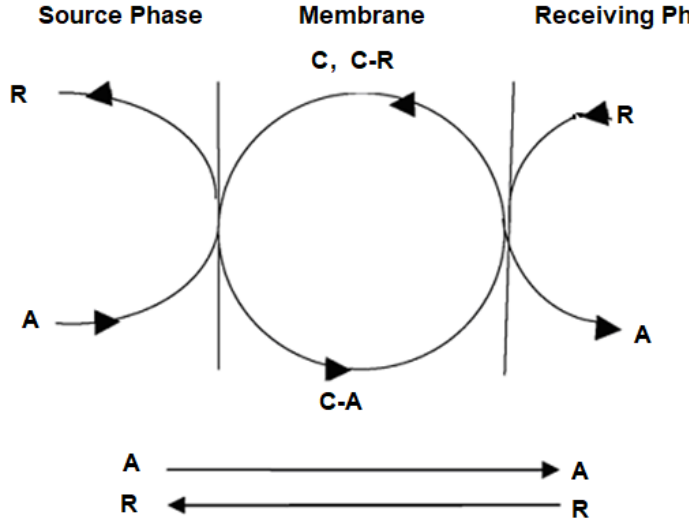
Figure 1. Membrane reaction systems: A — target chemical species; C — carrier; R — reagent.